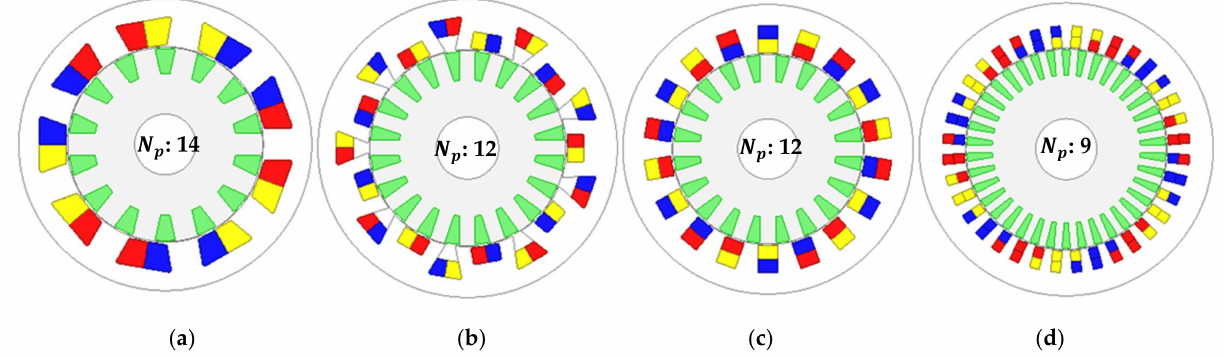
Figure 14. Two-dimensional views of IMs designed with FSCW, ANW, and ISDW topologies. ( a ) 9S/6P/14R-DL ( y c = 1); ( b ) 18S/6P/20R-DL (ANW); ( c ) 18S/6P/20R-DL ( y c = 2); ( d ) 36S/6P/38R-DL ( y c = 5).